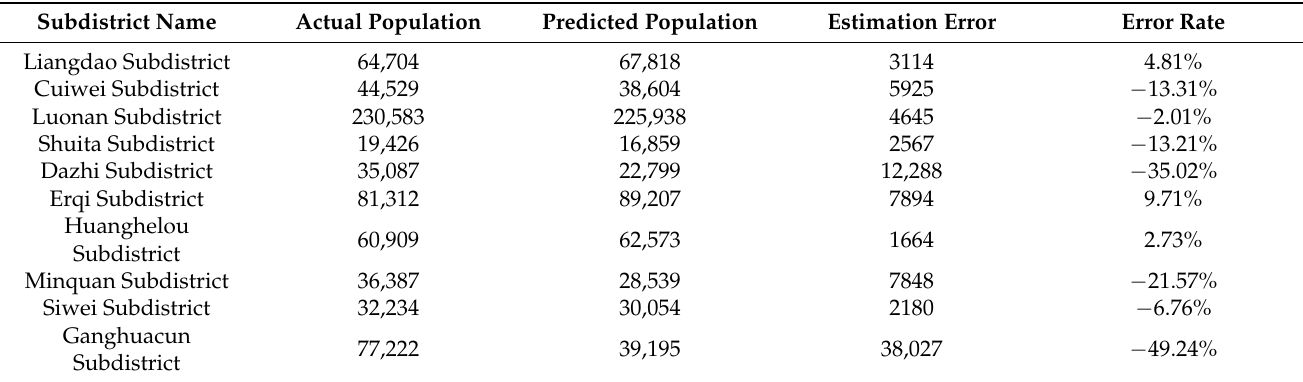
Figure 6. Residuals of the training set used in the population estimation model. Table 3. Estimated error of the